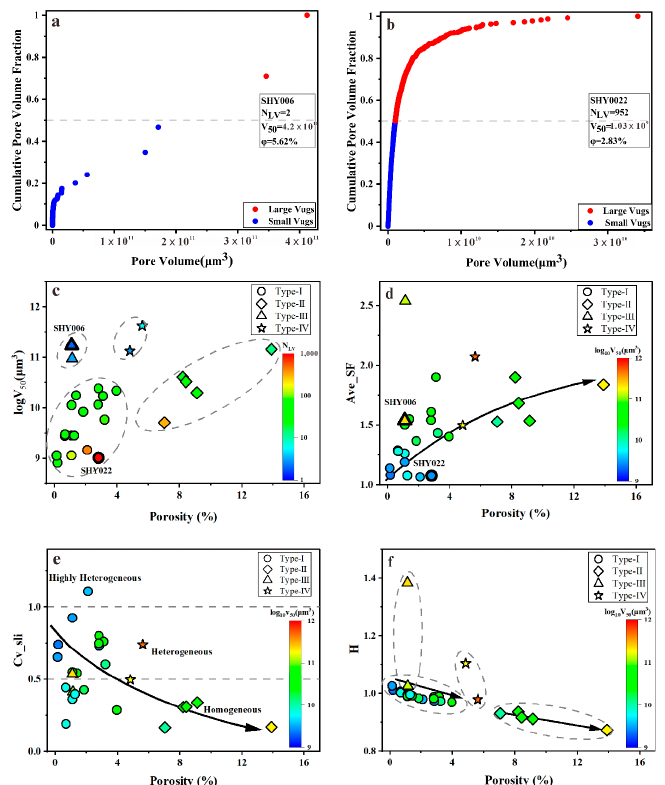
Figure 10. Cross plots of porosity and pore geometrical parameters and heterogeneity parameters. Marker shape represents pore type. ( a ) Pore volume cumulative curve of sample SHY006. Long axial vugs are developed along the cracks, with a diameter of 3–4 mm. ( b ) Pore volume cumulative curve of sample SHY022. A multitude of flat vugs are developed with a diameter of 1–2 mm and distrib ‐ uted in a laminar structure. ( c ) Cross ‐ plot of porosity and dominant pore volume (log 10 V 50 ) with the number of large vugs superimposed in color. ( d ) Cross ‐ plot of porosity and average shape factor ( Ave_SF ) with dominant pore volume (log 10 V 50 ) superimposed in color. ( e ) Cross ‐ plot of porosity and the coefficient of variation of CT slices with dominant pore volume (log 10 V 50 ) superimposed in color. ( f ) Cross ‐ plot of porosity and heterogeneous factor with dominant pore volume (log 10 V 50 ) su ‐ perimposed in color.